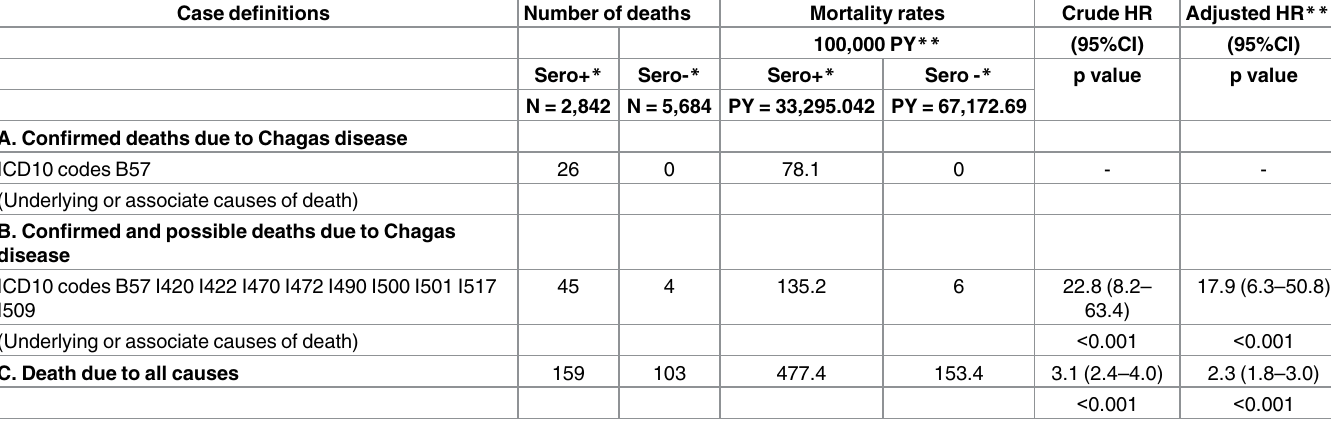
Table 4. Mortality numbers and rates for the cohorts of individuals seropositive for Chagas disease or seronegative for all screening tests at FPS, S ã o Paulo, Brazil, from 1996–2000. Estimated crude and adjustedhazard ratios, for three different mortality case